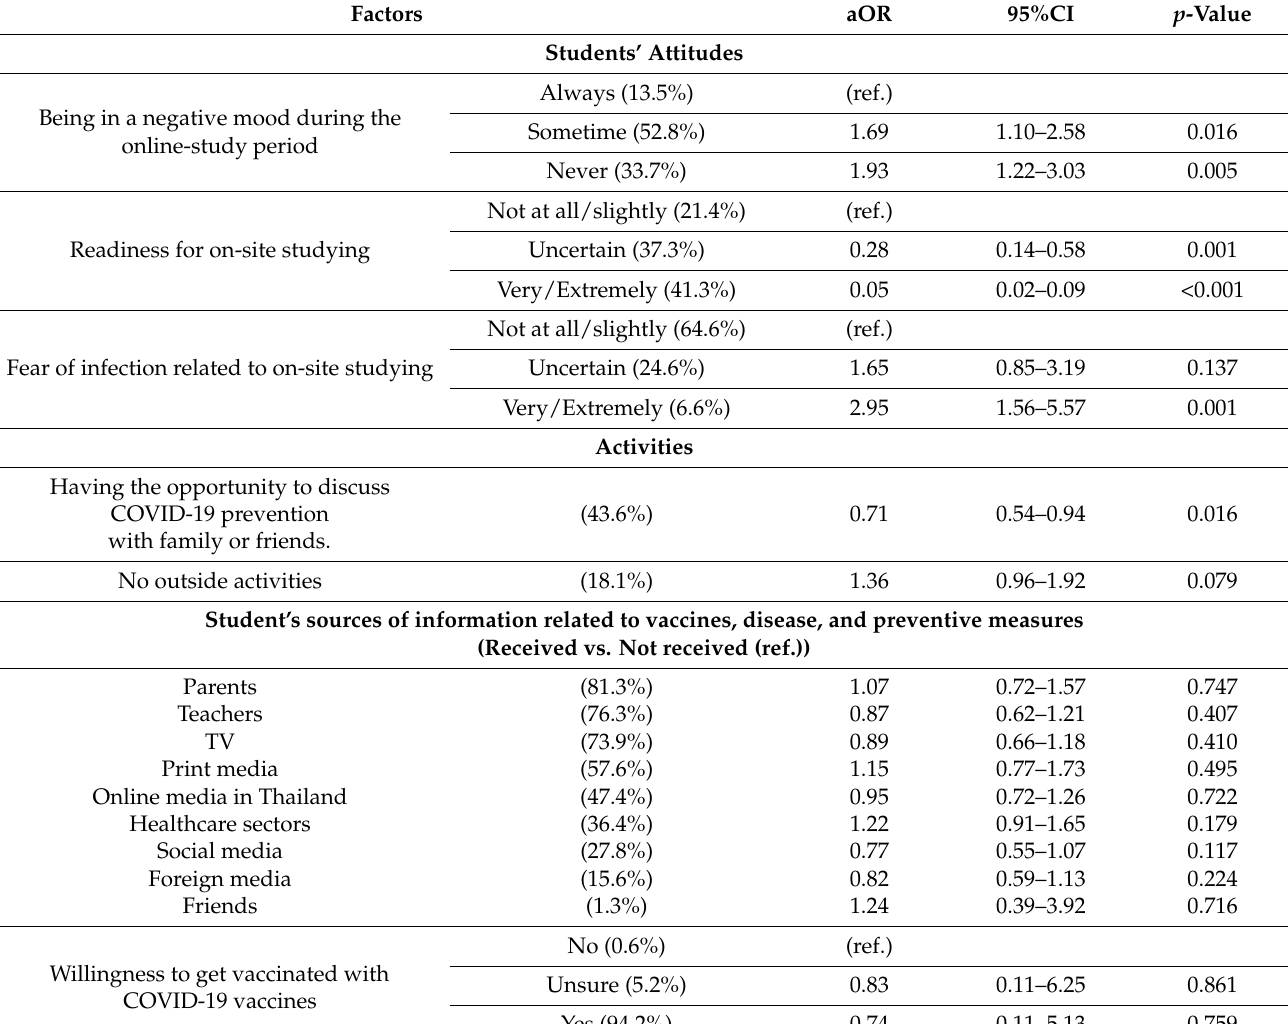
Table 2. Factors related to on-site-study hesitancy of high-school students. Factors aOR 95%CI p -Value Students’